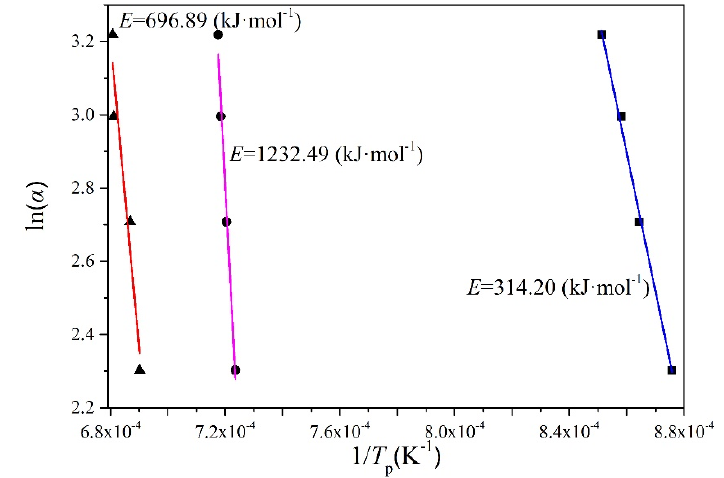
Figure 4. ln( α ) ~1/ T p fitting line of the